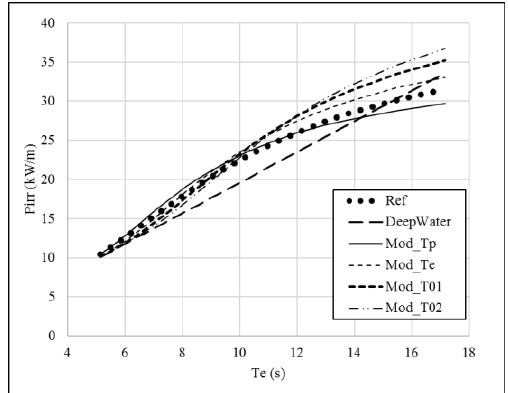
Figure 8. Modifications of the wave energy assessments using different characteristic periods ( h = 25 m).